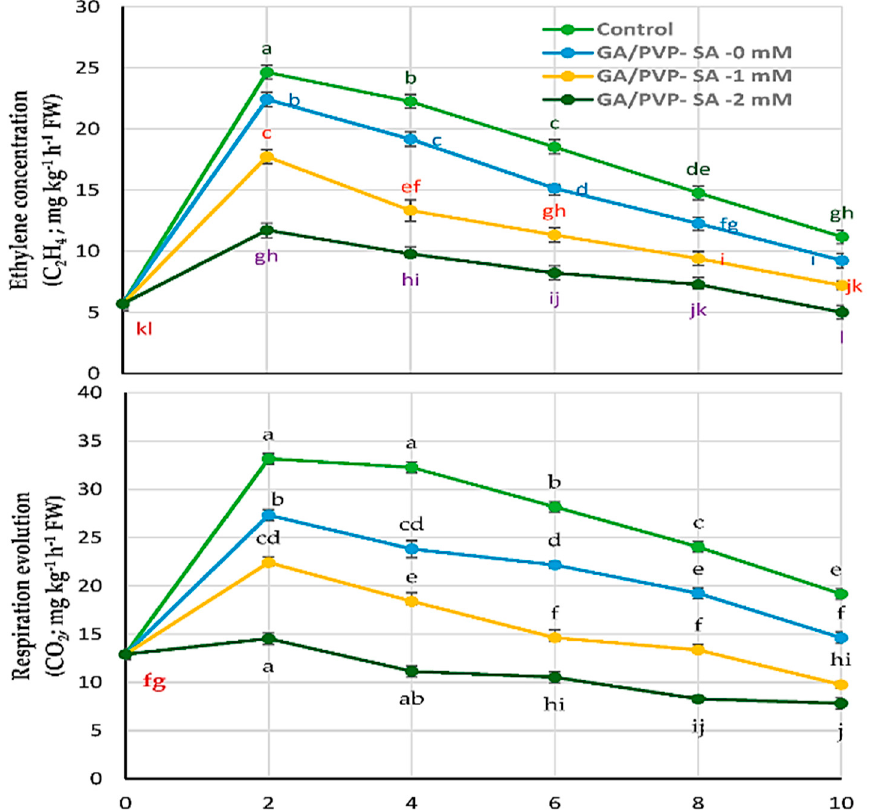
Figure 2. Effect of different treatments of gum arabic (GA) and polyvinylpyrrolidone (PVP) blended with salicylic acid (SA) at different concentrations as a mixture biopolymer coating treatment (GA/PVP–SA) on ethylene and respiration production rate of peach fruit ‘Early Sweet’ during shelf life at ambient air (29 ± 1 °C and air humidity 51%) during two seasons (2020 and 2021).